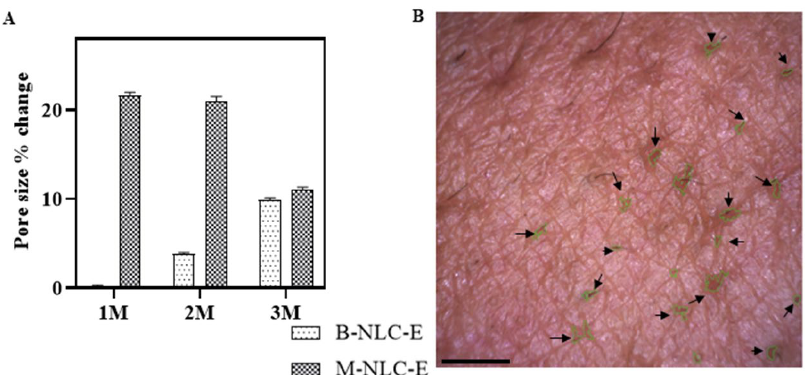
Figure 16. Pore sizes of the skin ( A ) after 1st (M1), 2nd (M2) and 3rd month (M3) of use of B-NLC- E and M-NLC-E ( B ) Pore size after 3rd month. Scale bar is 1 µ m. Images were taken through Vi- sioscan attached with CSI. Data shown as means ± SD.